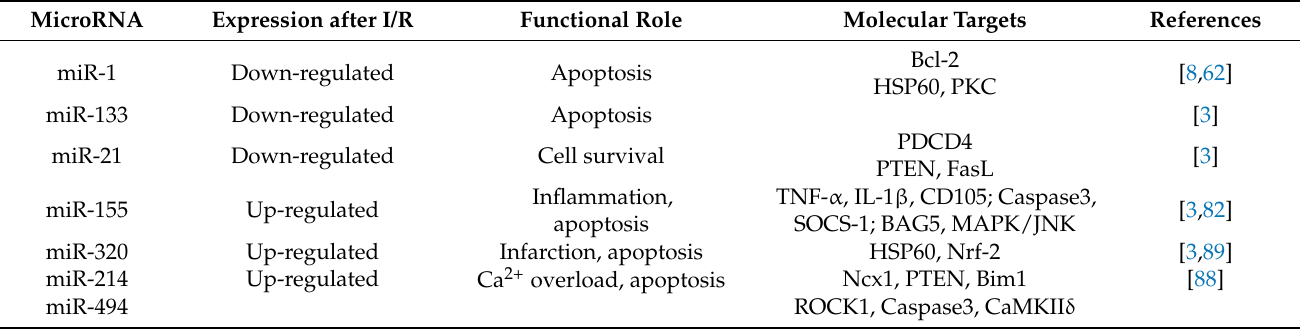
Table 2. MicroRNAs and their function in myocardial ischemia–reperfusion (I/R) injury. MicroRNA Expression after I/R Functional